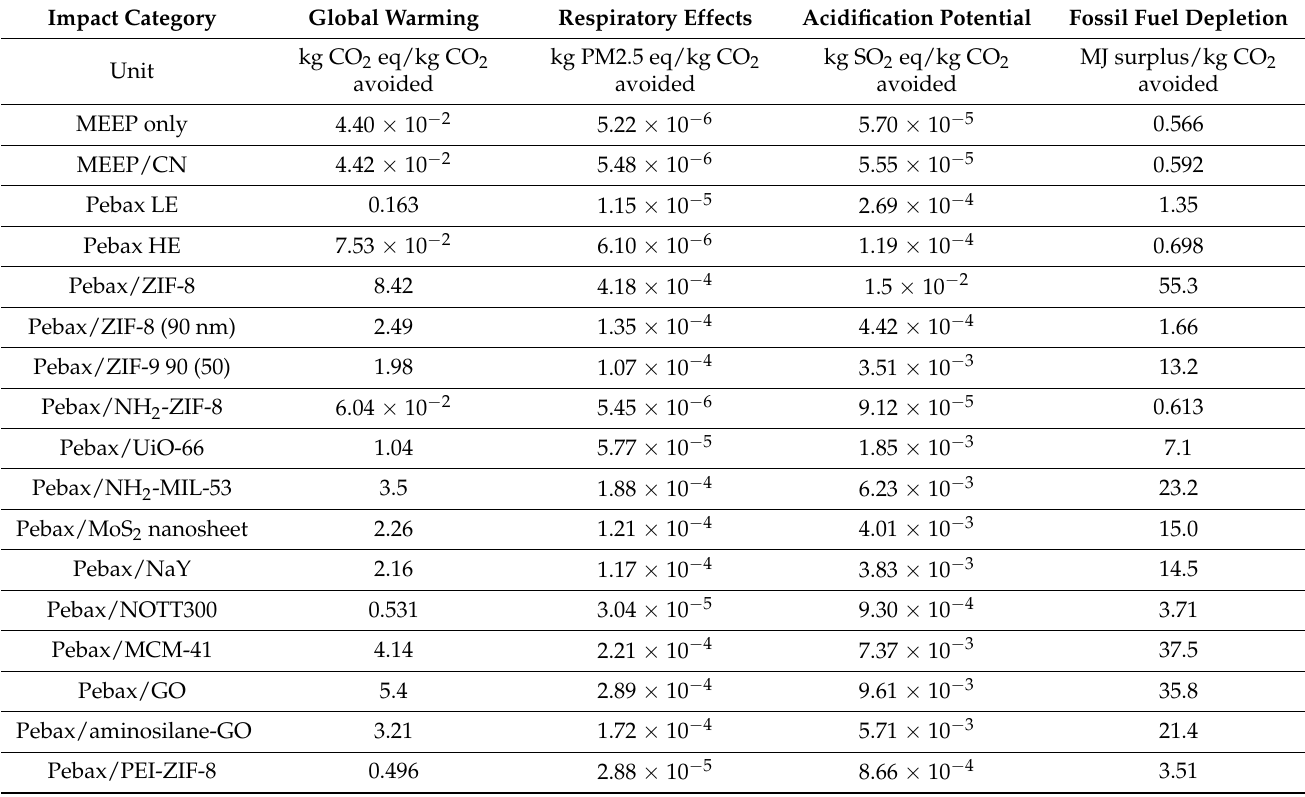
Table 3. Comparison of environmental impacts for different